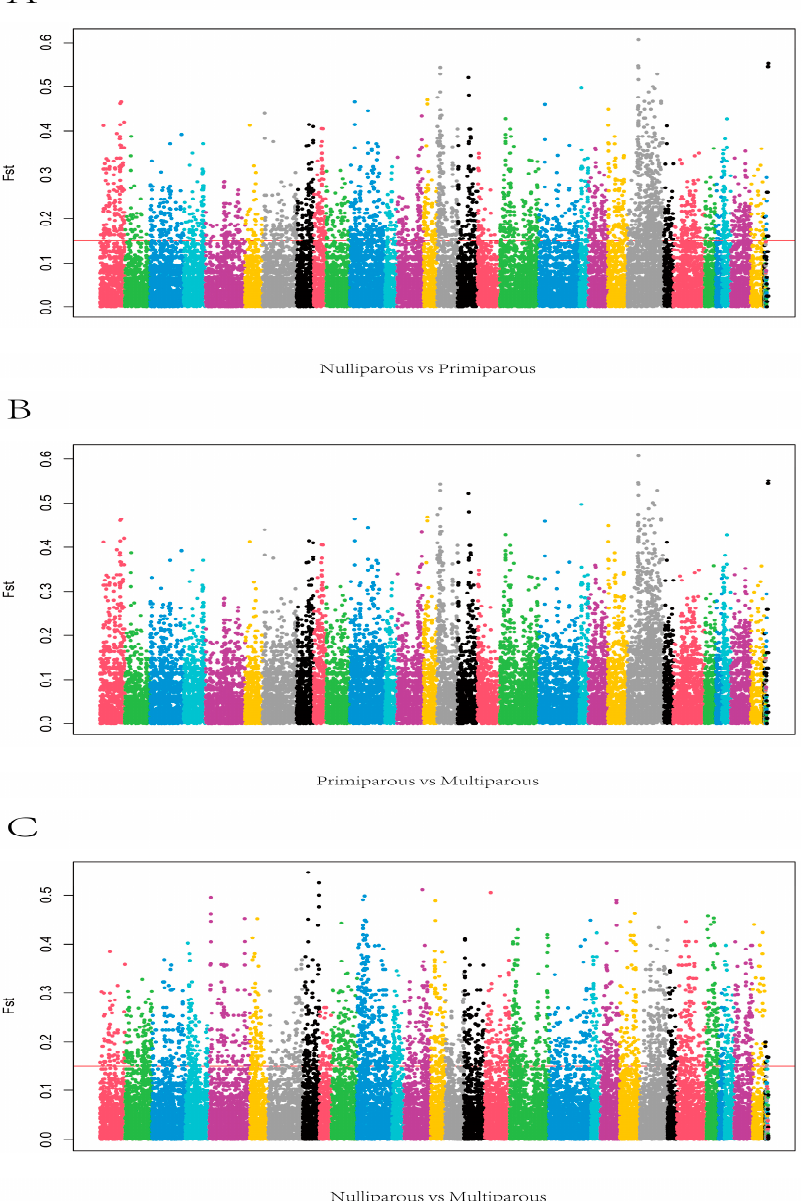
Figure 8. ( A ) Manhattan plots SPs in nulliparous compared with primiparous period ( B ) Manhat- tan plots SPs in primiparous compared with the multiparous period. ( C ) Manhattan plots SPs in nulliparous compared with the multiparous